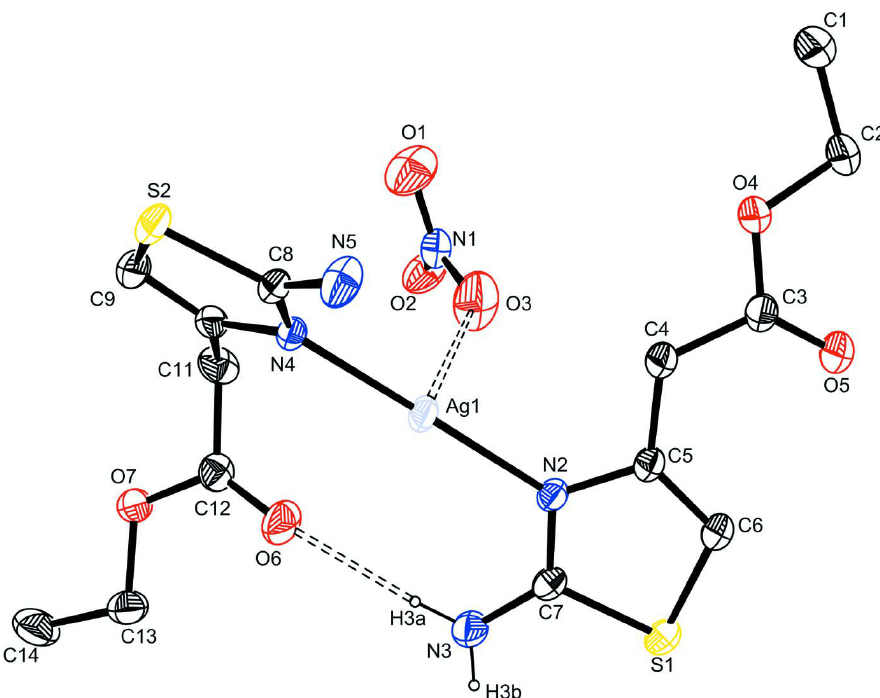
Figure 1 A view of complex (1), with the atom-labeling scheme. Displacement ellipsoids are drawn at the 30% probability level. H bond and weak Ag···O interactions are shown as dashed lines. Only H atoms involved in hydrogen bondings are shown. H atoms are drawn as small spheres of arbitrary